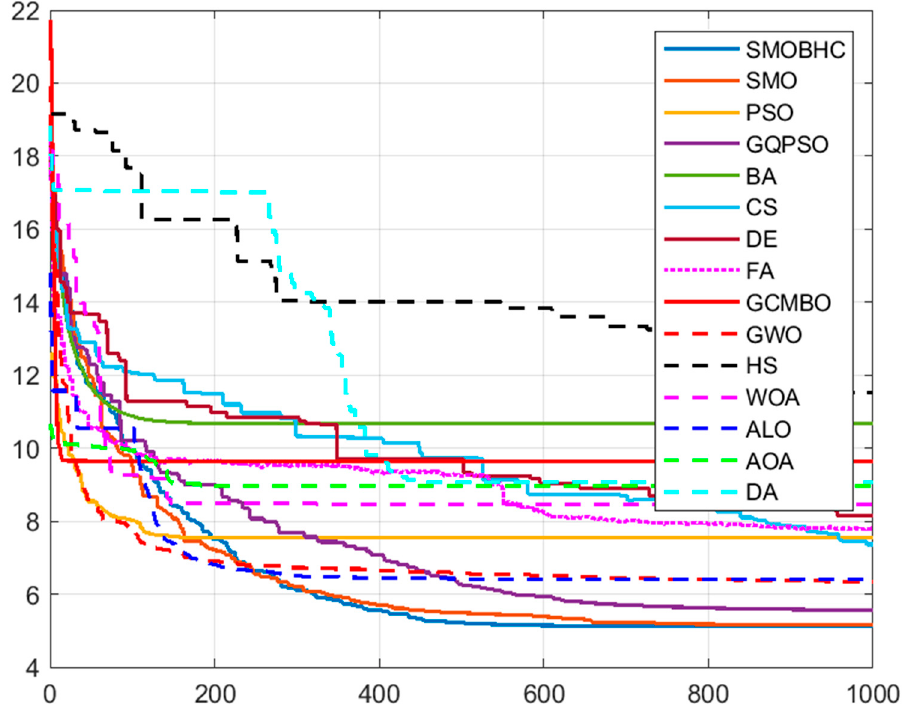
Figure 15. Comparative convergence curves of algorithms for battlefield 2 with 𝐷 = 90 .